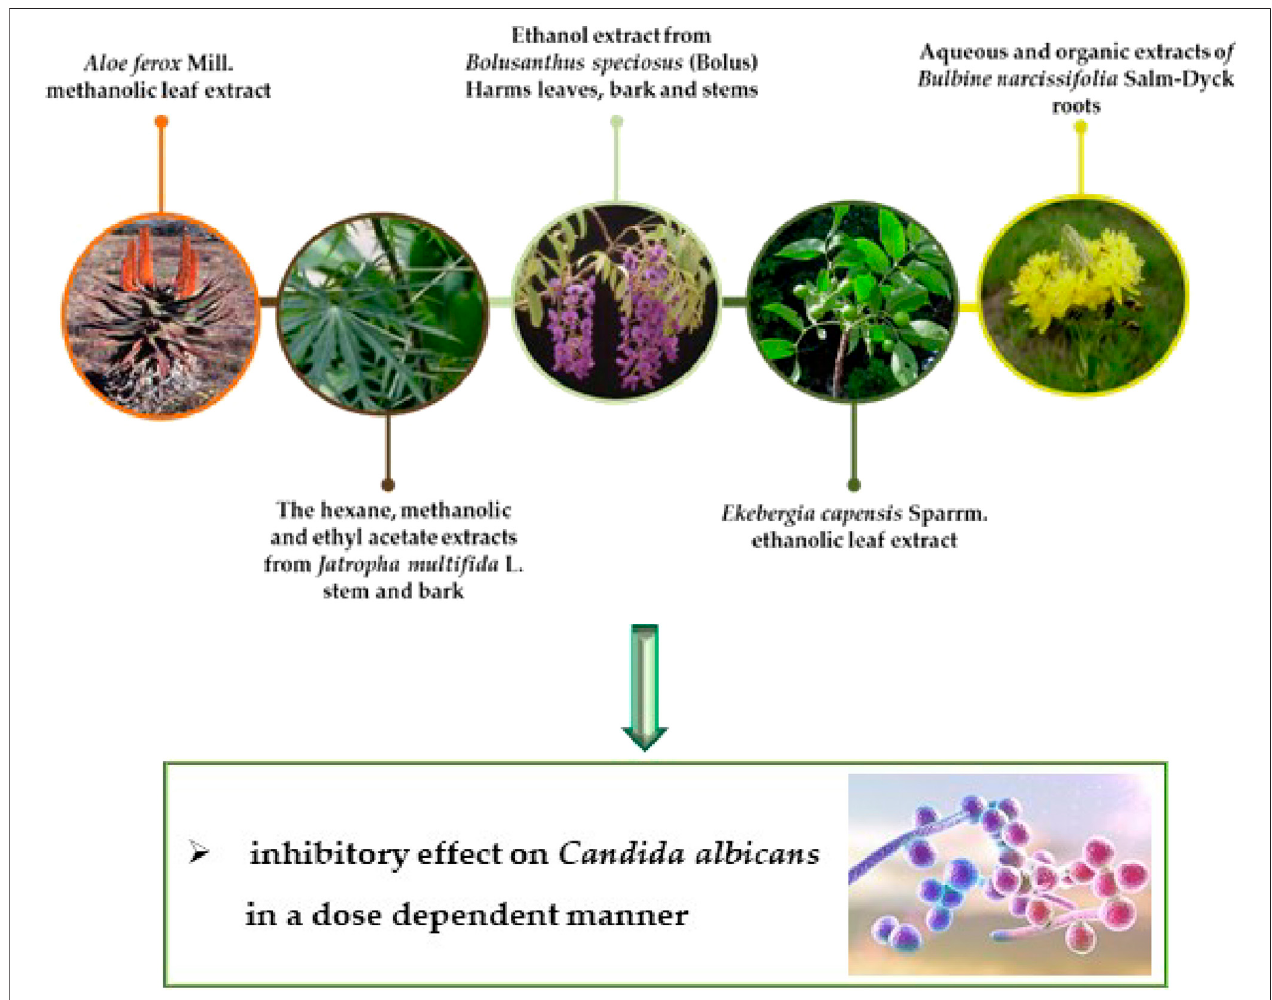
FIGURE 4 | Representation of the selected bioactive plant species against STDs caused by fungus.